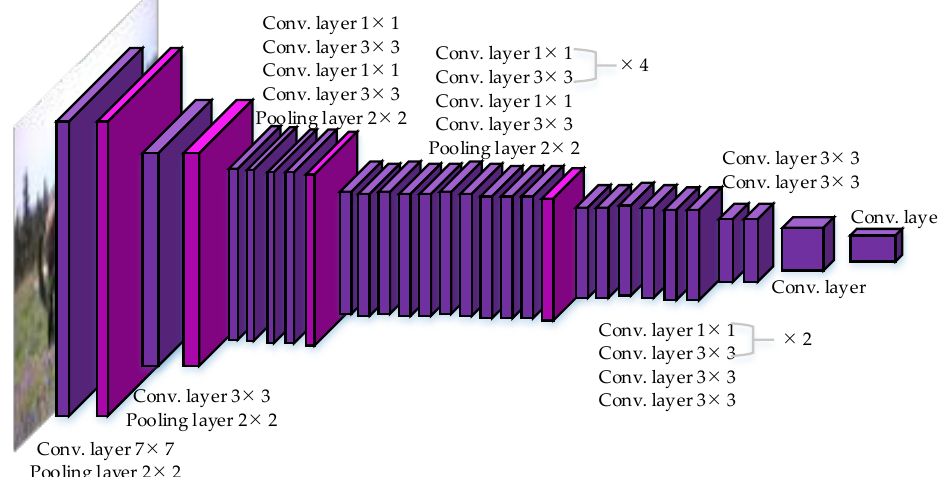
Figure 3. The network structure of YOLO, the purple ones are convolutional layers, the purple-red ones are max pooling layers. The structure has 26 convolutional layers and 4 max pooling layers. The layers are for extracting features of the objects, the rear layers are for classification of the objects. The design of the structure should have some fixed routines. The planes reflect the size of the feature maps. The dimension of the network is not shown in the figure. The video frame shown in the figure is from the YouTube Objects (YTO) dataset [19].